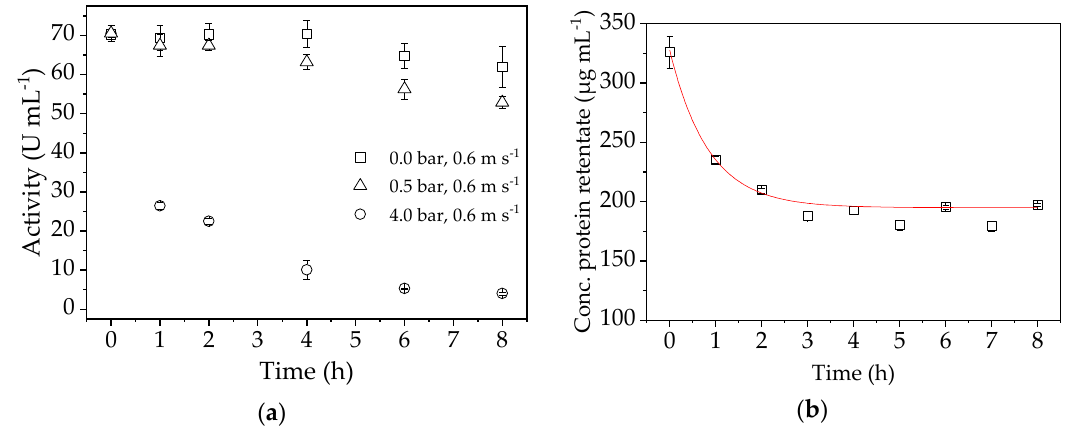
Figure 9. ( a ) Activity of the enzyme during stability tests at TMPs of 4.0, 0.5, and 0 bar. ( b ) Protein concentration in the retentate samples determined by bicinchoninic acid (BCA) assay.